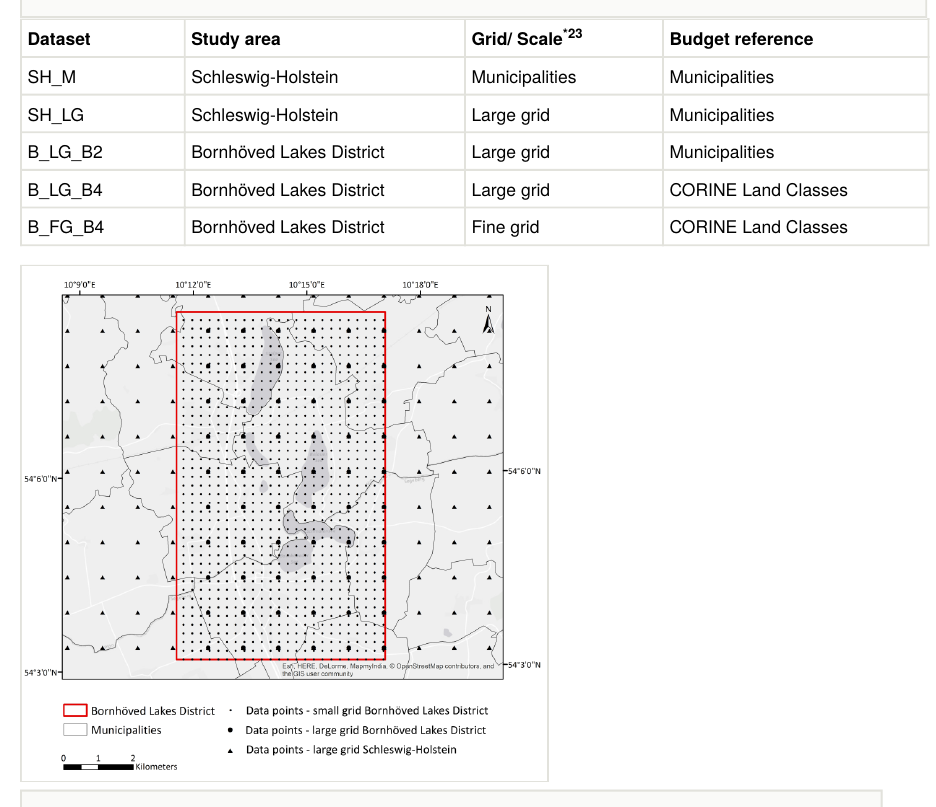
Assessment units for Schleswig-Holstein and the Bornhöved Lakes District: Large and fi ne point grid (data on administrative boundaries from GeoBasis-DE / BKG